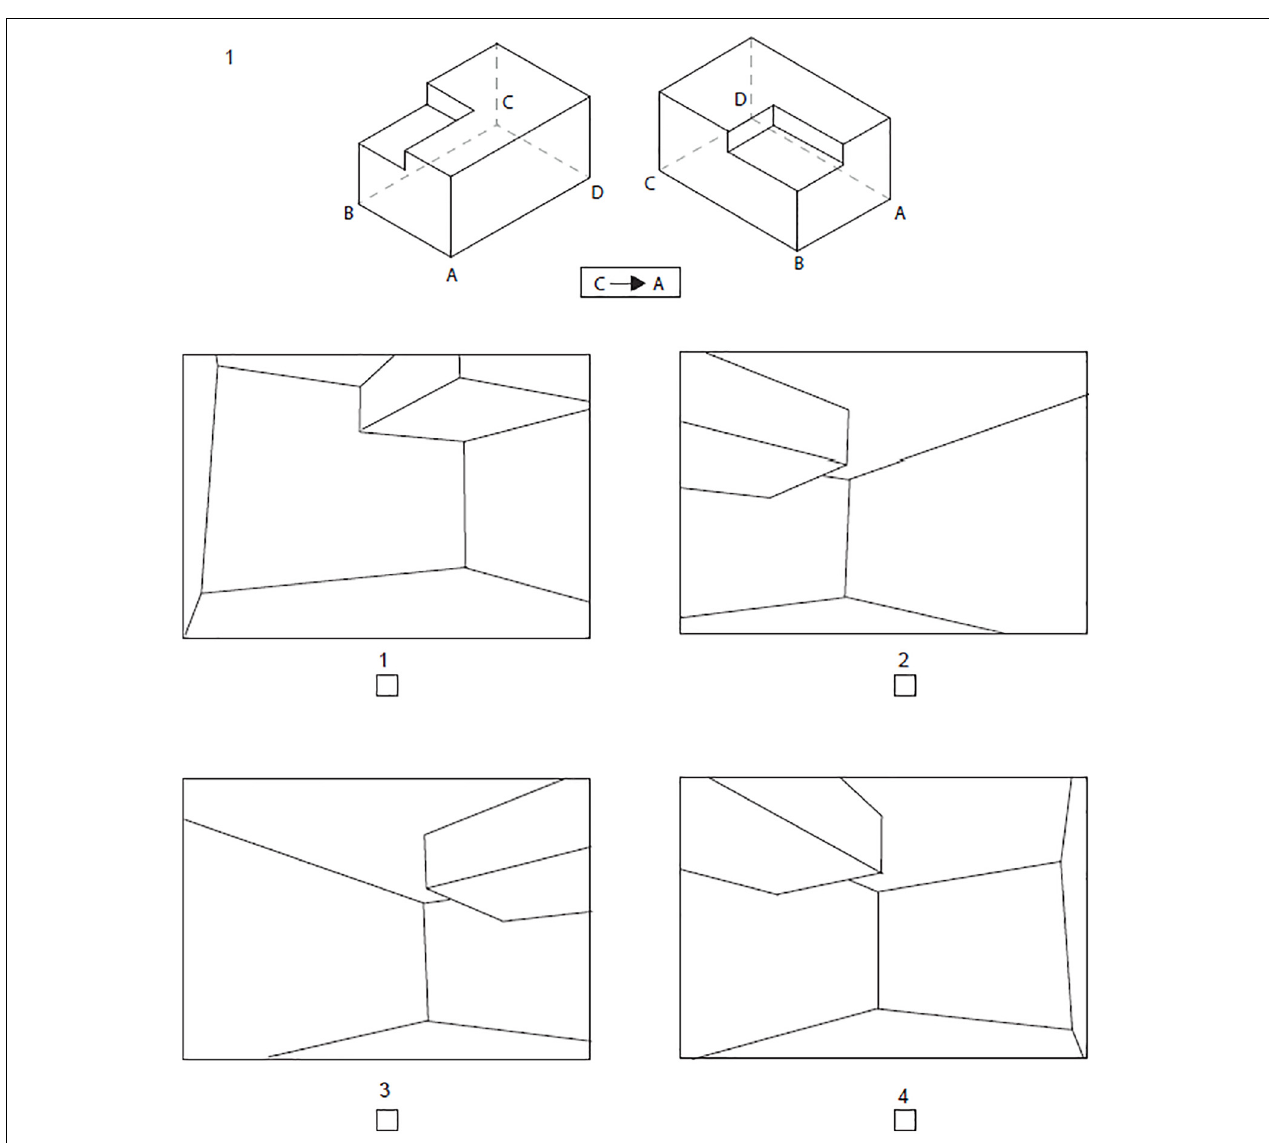
FIGURE 2 | Example item from Indoor Perspective Test. Participants had to imagine themselves standing inside the object at point C and looking toward point A.